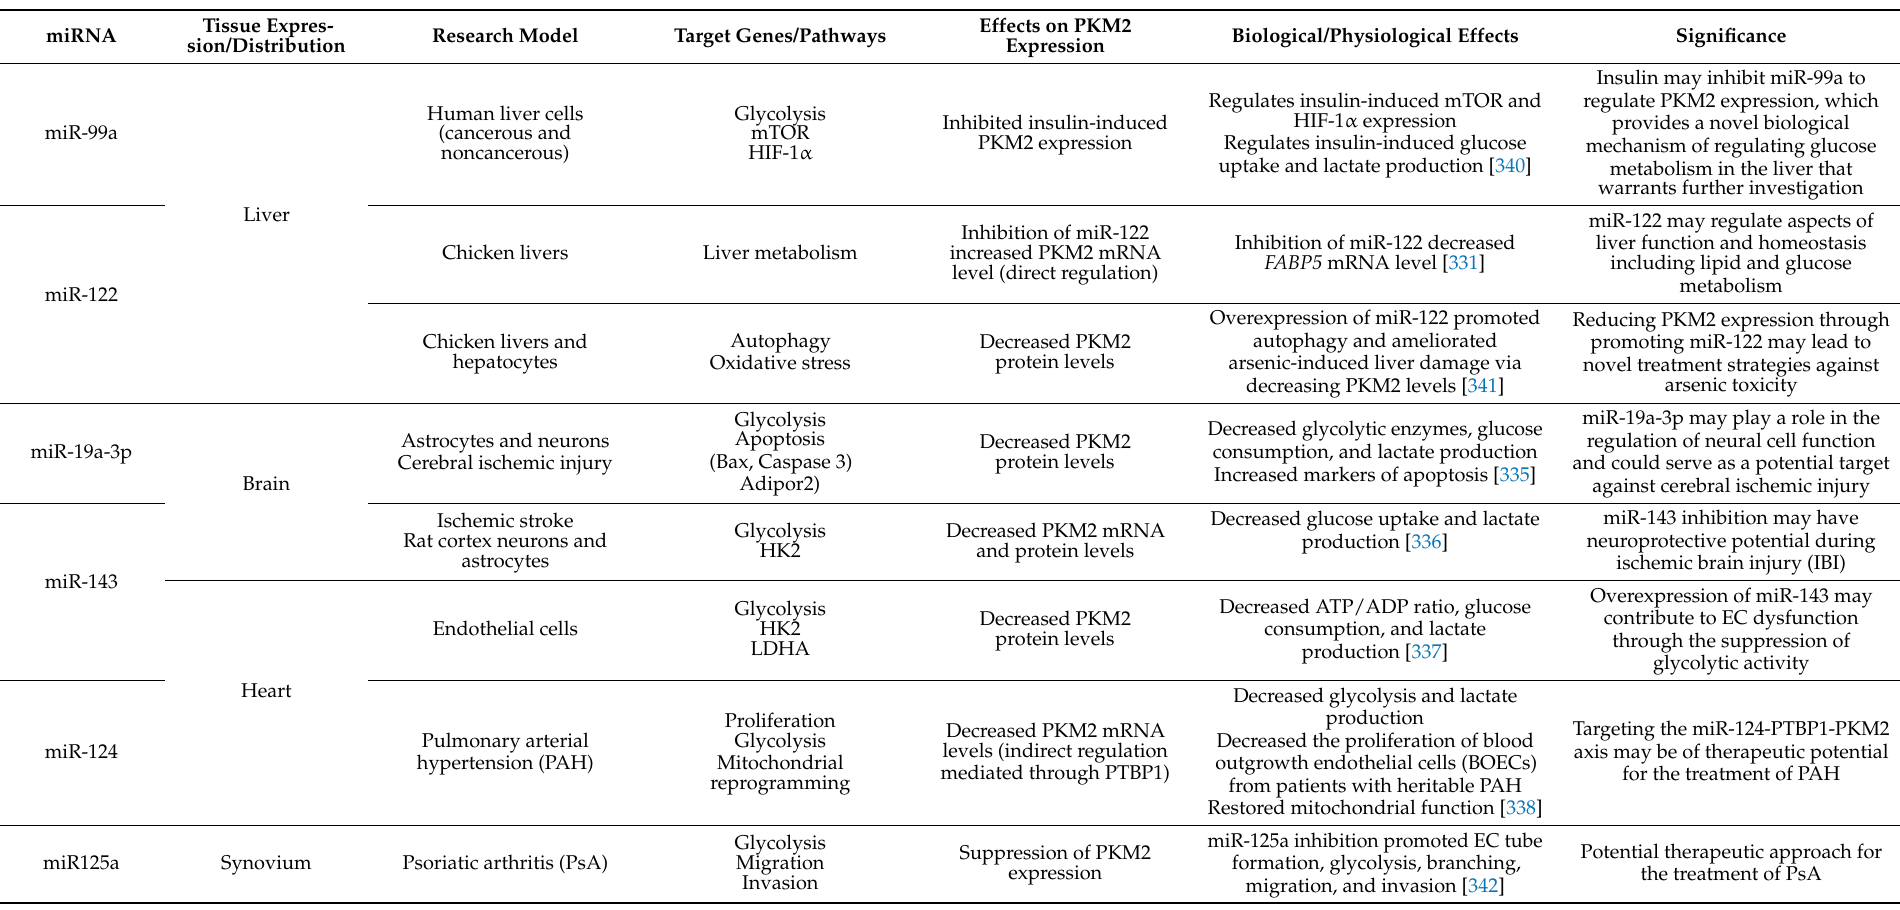
Table 2. Roles of some PKM2-associated microRNAs in non-cancer